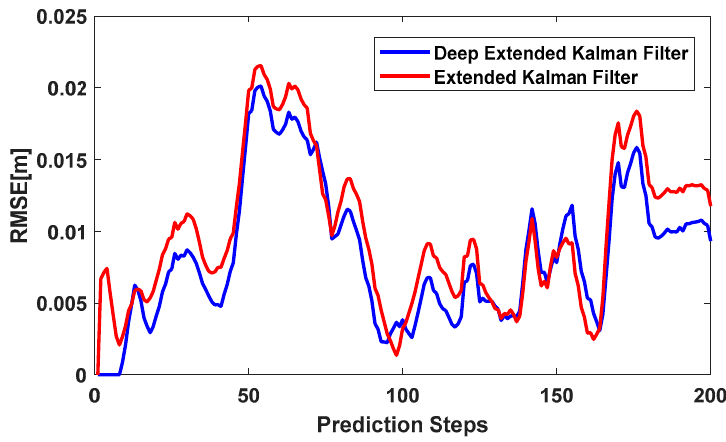
Figure 7. RMSE of the deep extended Kalman filter and extended Kalman filter. The deep extended Kalman filter IMU modelling was based on LSTM with a sequence length of 10.